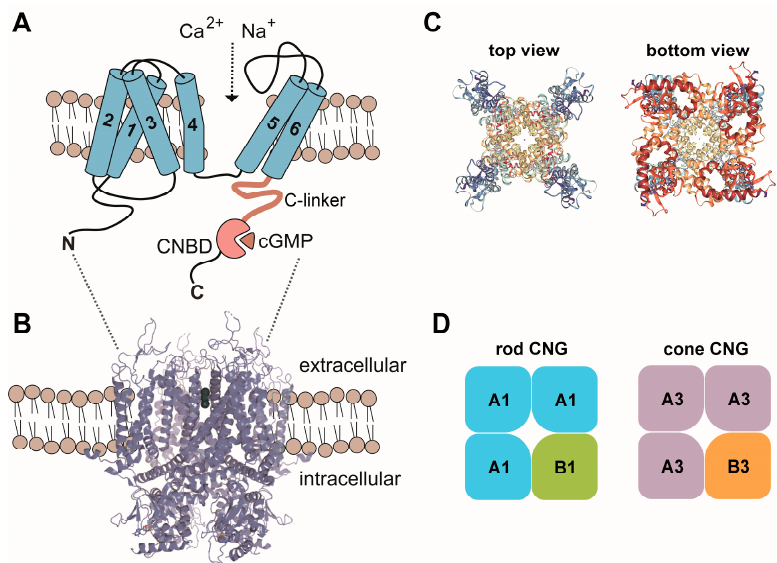
Figure 1. ( A ) Membrane topology of CNG channel subunits. 1–6, transmembrane segment 1–6; C, carboxy-terminus; CNBD, cyclic nucleotide binding domain; N, amino-terminus. ( B ) Model of the CNG channel complex embedded in the plasma membrane based on the TAX-4 structure. ( C ) Top and bottom views of the tetrameric TAX-4 C. elegans CNG channel complex. ( D ) Subunit composition of the CNG channels from rods and cones. A1, CNGA1; A3, CNGA3; B1, CNGB1; B3, CNGB3. Structures in this figure were generated with the RSCB PDB 3D View tool (www.rcsb.org/3d-view/) based on PDB 5H3O.